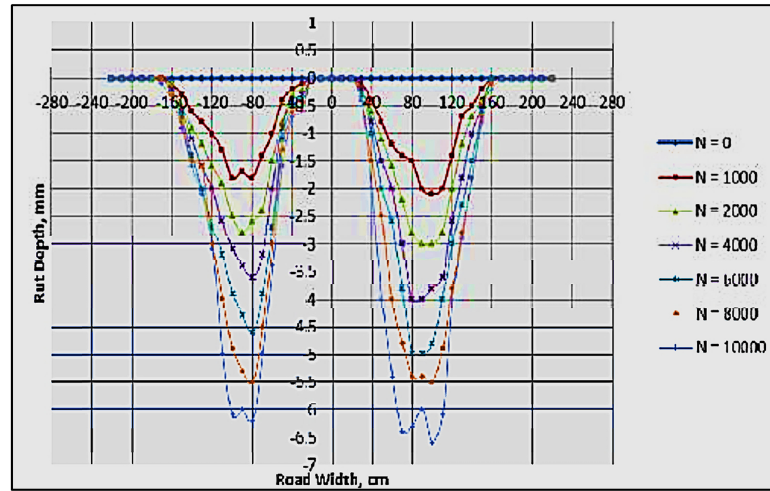
Figure 18: Rutting depth at interfaces I + II +